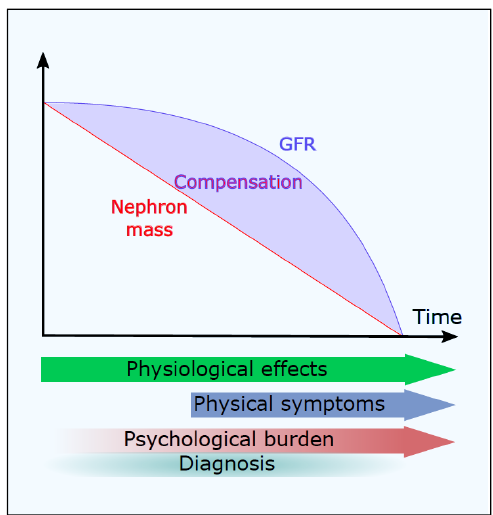
Figure 1. The natural history of autosomal dominant polycystic kidney disease as depicted by renal function decline as well as the onset of physical and psychological symptoms. Reductions in total nephron mass are masked by compensatory changes in glomerular filtration rate (GFR) such that total GFR remains apparently normal for many years until compensation fails. Subclinical physiological changes are detectable from the earliest stages of disease (for example, in children), whereas clinical symptoms usually occur later. The psychological burden of having the diagnosis made is generally underestimated.